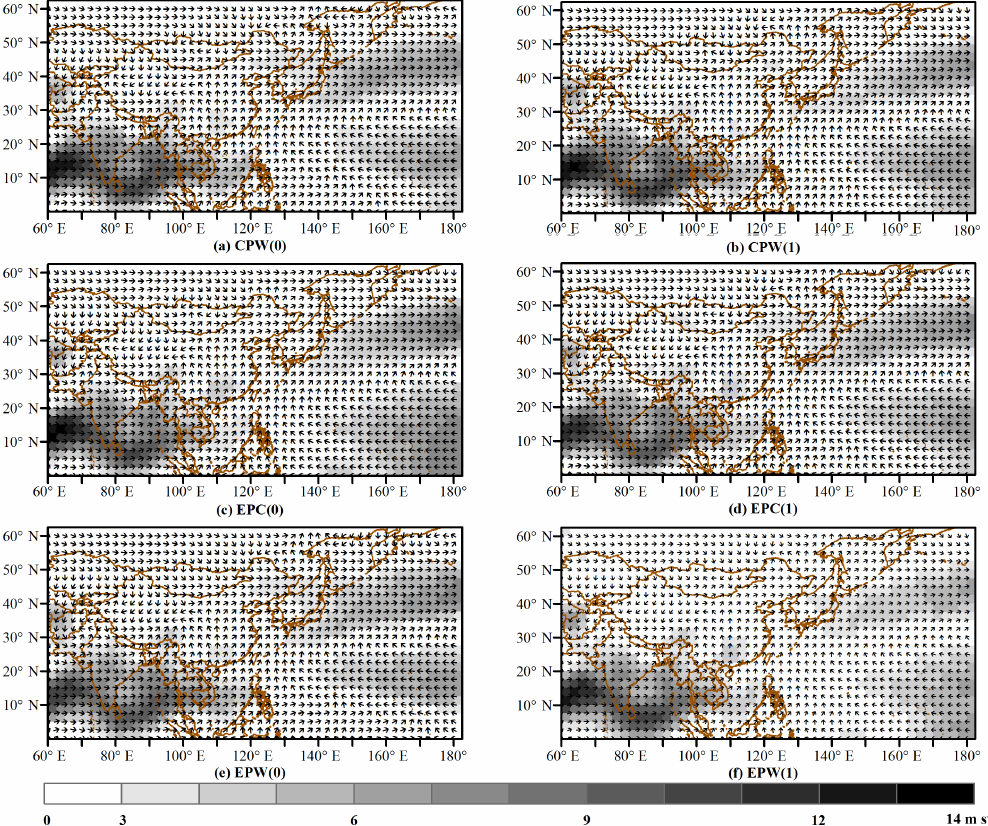
Figure 5. Composites of 850mbar vector wind for mainland China during CPW, EPC and EPW developing (0) and decaying (1) phases. Arrows show the direction of wind (ms − 1 ); grey shaded areas denote wind speed above 3ms − 1